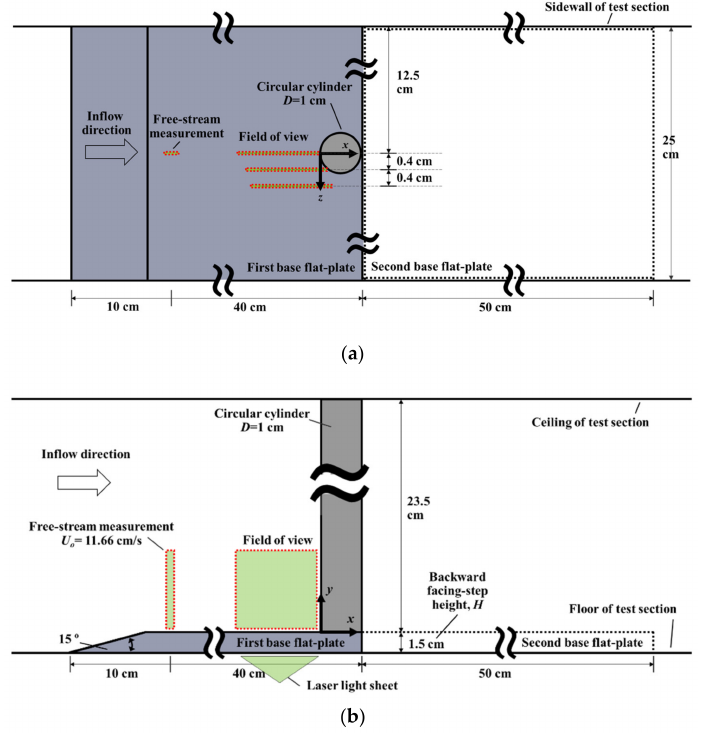
Figure 1. Experimental setup for H / D = 0 and 1.5 (with and without the second base flat-plate in place, respectively): ( a ) top view and ( b ) side